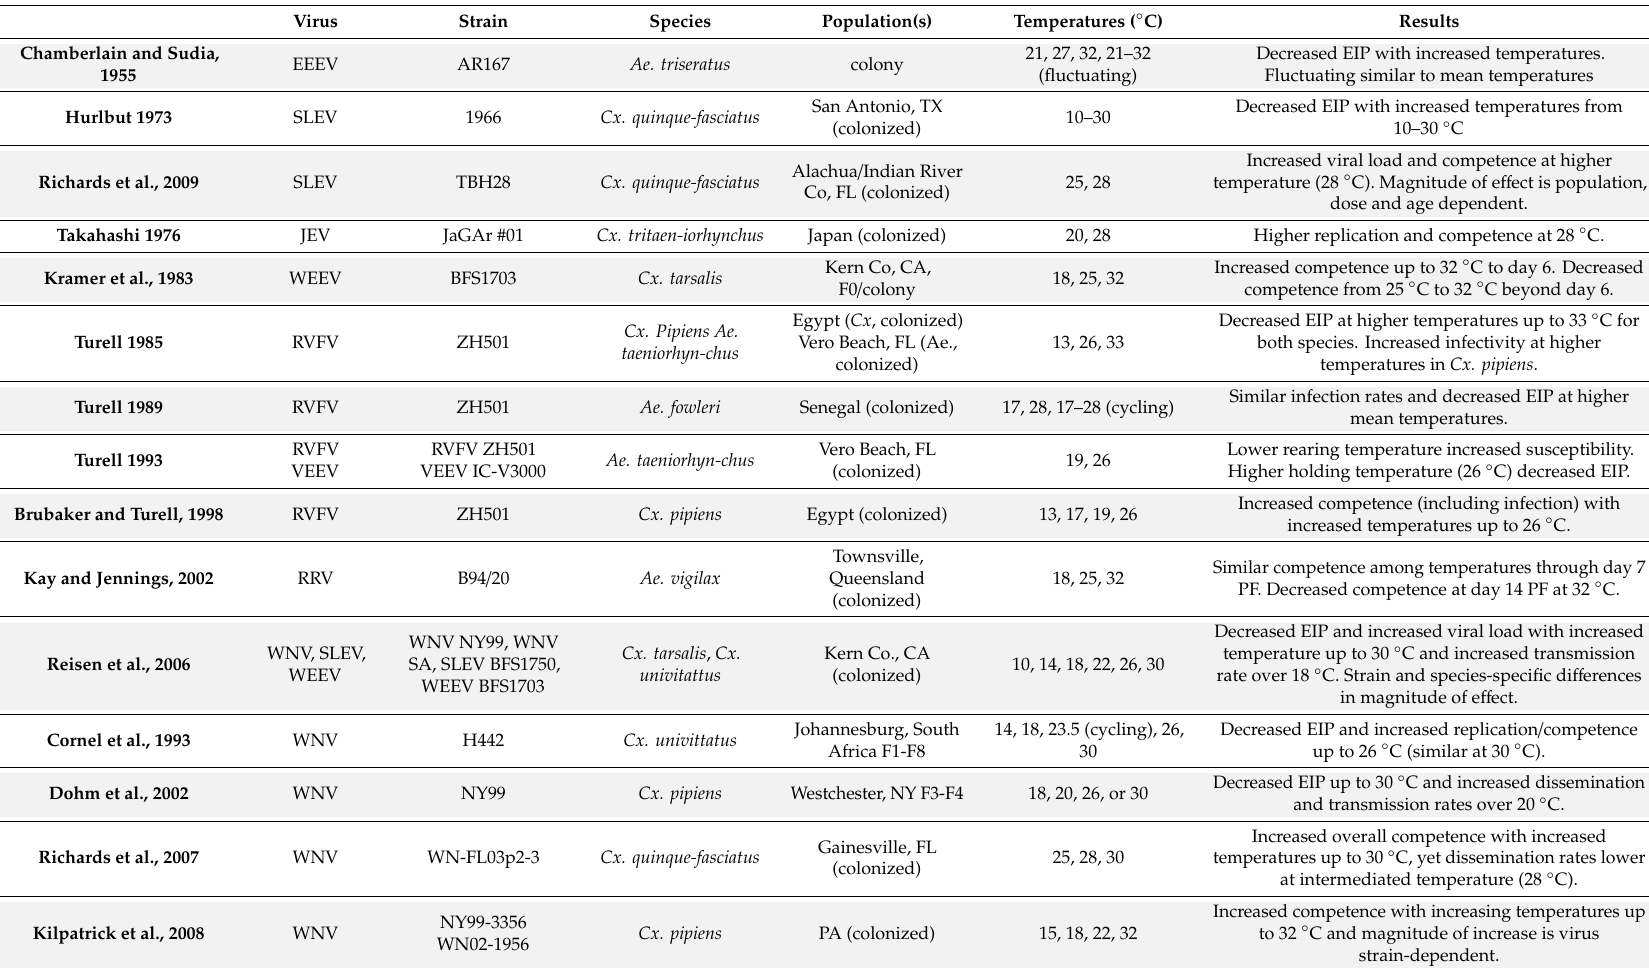
Table 2. E ff ect of temperature on vector competence for zoonotic